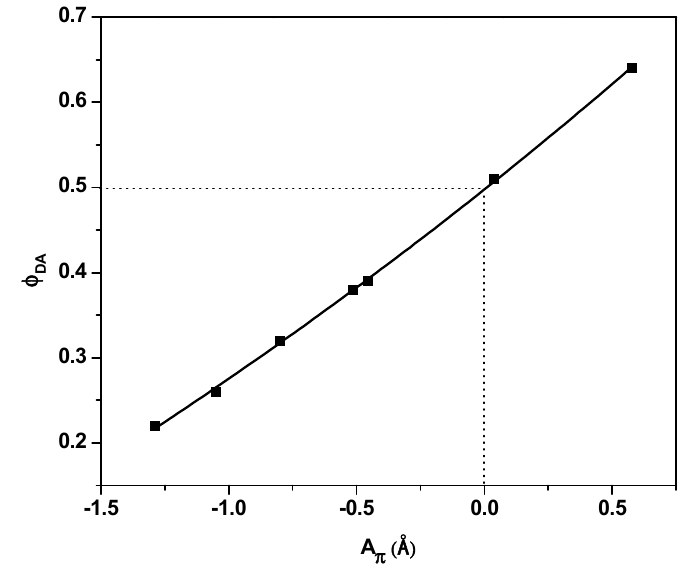
Figure 8. Photoluminescence quantum yield versus A π with varying PQD contents.